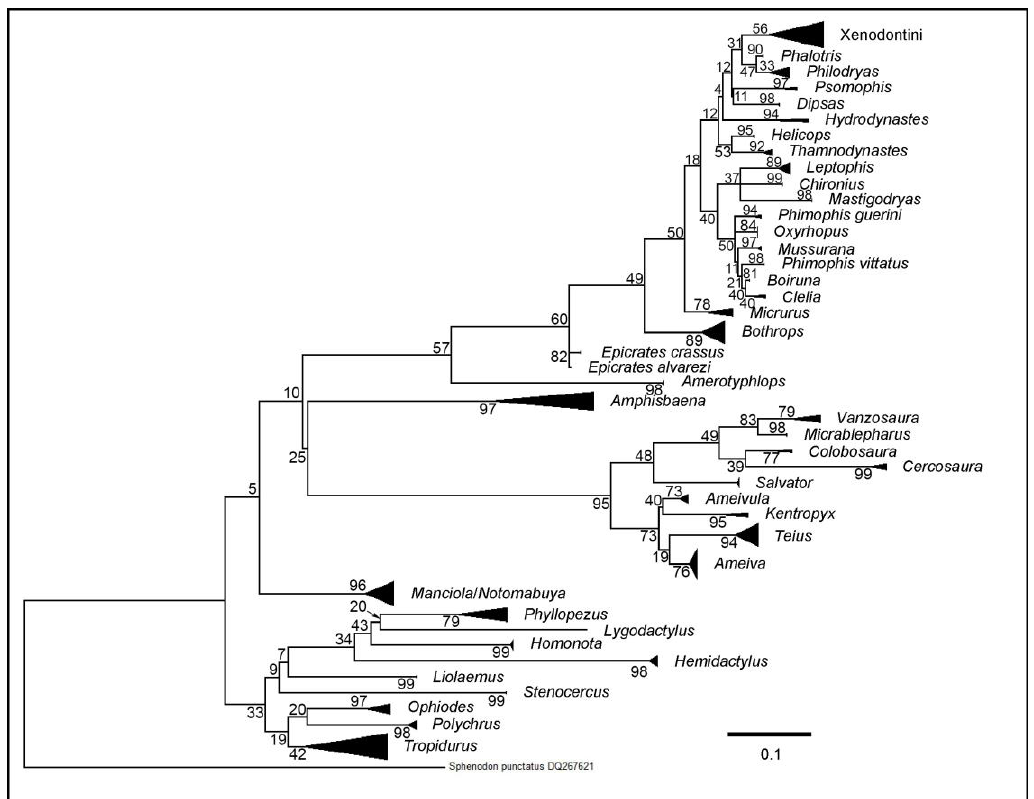
Figure 4. General view of the barcoding tree performed with a Maximum Likelihood approach. Clades are collapsed (in genera or tribes) for a better visualization. Numbers on nodes represent Bootstrap values. The scale bar represents branch length (substitutions/site).